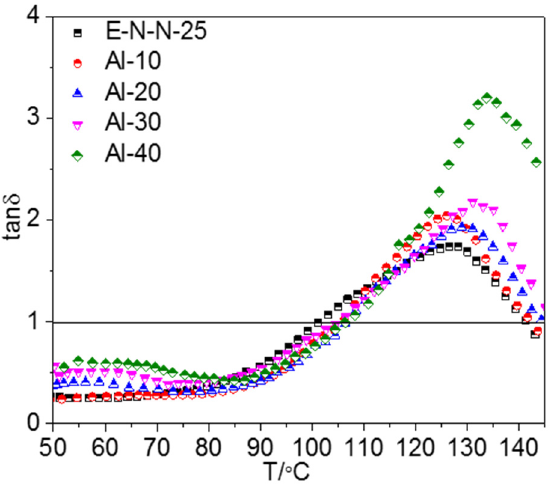
Figure 2. Loss factor (tan δ ) versus temperature curves of model propellants with different Al con- tents.